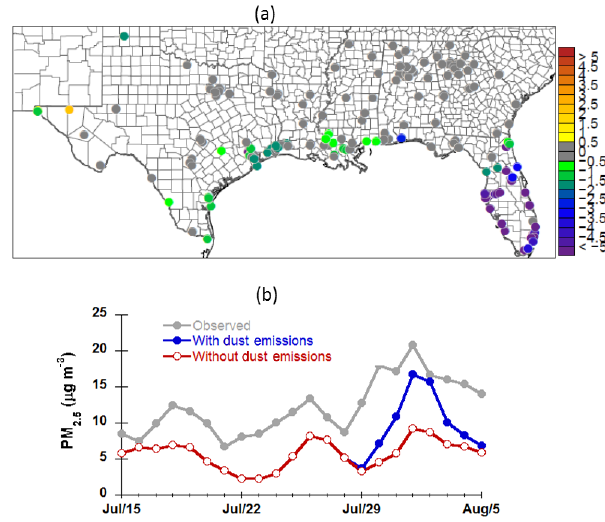
Figure 9. The impact of simulated transatlantic transport of Saharan dust on daily-average surface PM 2 . 5 in the Gulf of Mexico region. (a) Average change in bias in daily average surface PM 2 . 5 (µgm − 3 ) at AQS monitor locations between CMAQ simulations with and without considering dust emissions, 29 July–2 August 2006. Neg- ative changes in bias denote improvement in model performance by including Saharan dust emissions and representing their transat- lantic transport. (b) Comparison of modeled and observed daily- average surface PM 2 . 5 averaged over all AQS monitor locations in